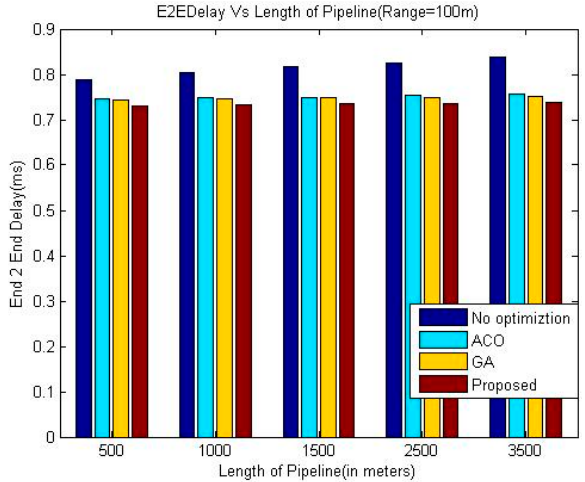
Figure 4. Comparison of End-to-End delay (Range 50 m).